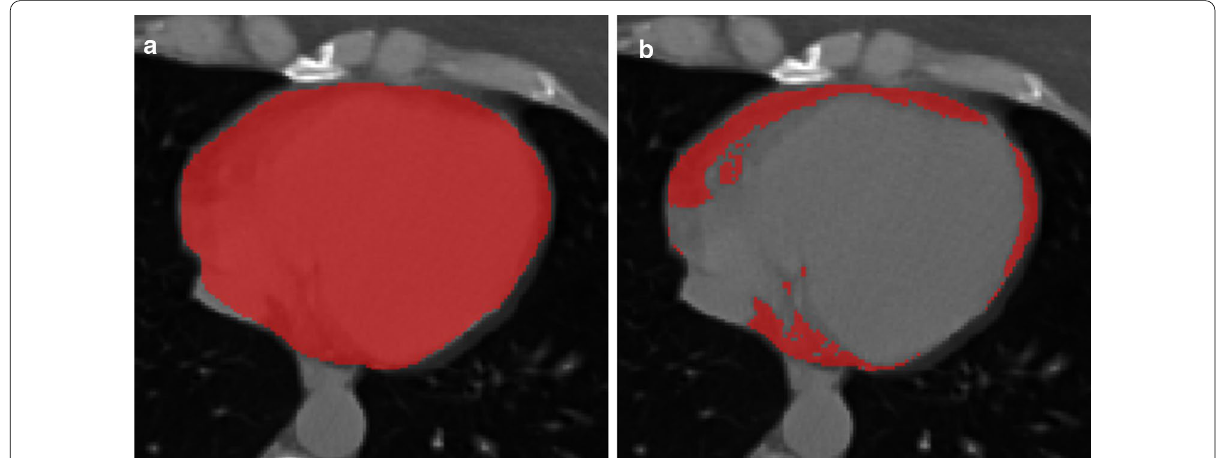
Fig. 1 Epicardial adipose tissue segmentation. a contouring of the pericardium; b subsequent thresholding between -190 and -30 Hounsfield units